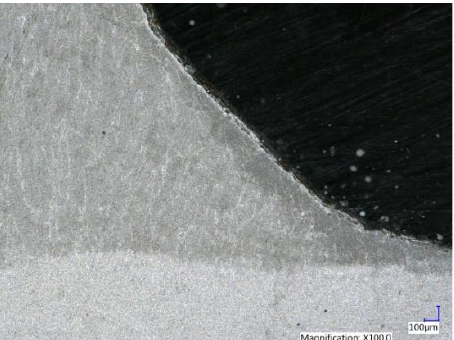
Figure 13. The microstructure of the transition area between fillet weld and the base material.